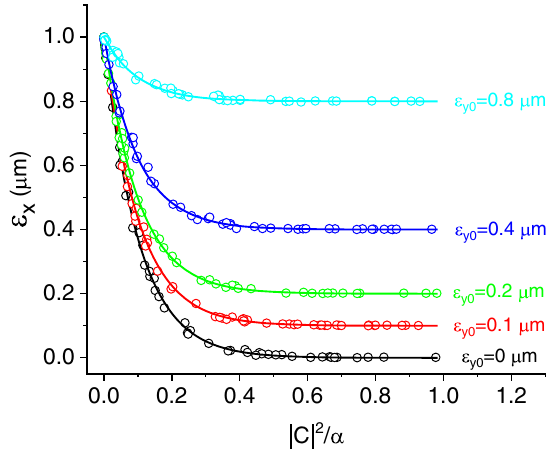
FIG. 4. Horizontal emittance after resonance crossing. Open circles are from tracking simulations, lines are from Eq. (18). The initial horizontal emittance is always 1 μ m while the initial vertical emittances are 0 = 0 . 1 = 0 . 2 = 0 . 4 = 0 . 8 μ m (black/red/light-